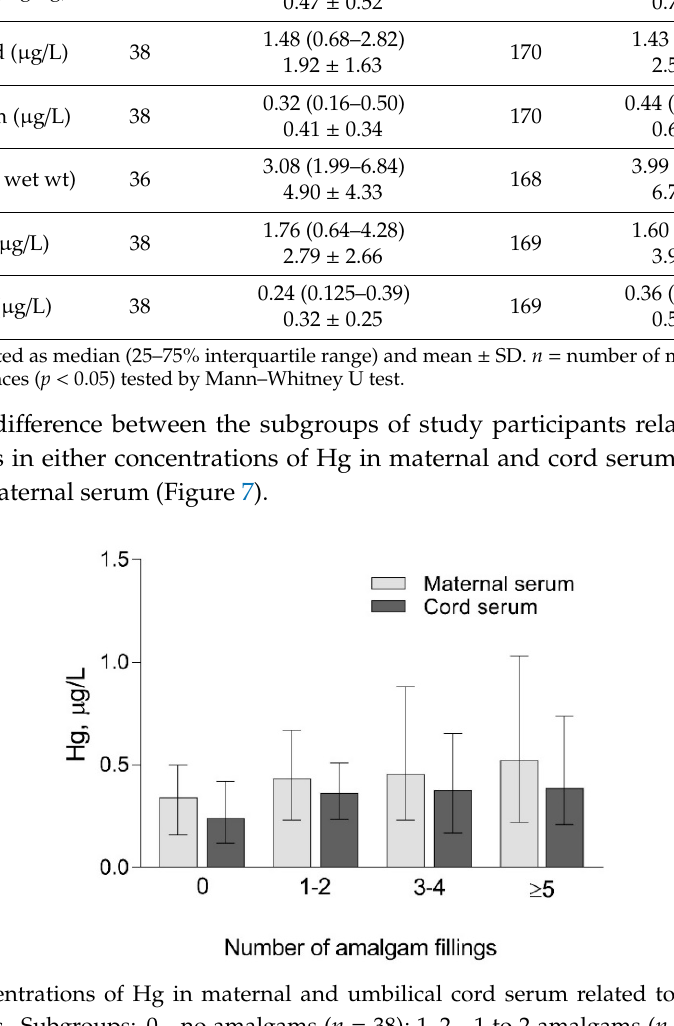
Figure 7. Concentrations of MT2 in maternal serum in the study participants from the coast ( n = 94) related to the number of amalgam fillings. Subgroups: 0—no amalgams ( n = 27); 1–2—1 to 2 amalgams ( n = 29); 3–4—3 to 4 amalgams ( n = 26); ≥ 5—5 or more amalgams ( n = 12). Data are presented as median and 25%–75% interquartile range. Spearman’s correlation coefficients (  s ) between maternal age, seafood (fish) consumption, number of amalgam fillings, maternal serum MT2, and the concentrations of Hg and Se in the measured samples are presented in Table 4. Maternal seafood intake positively correlated with virtually all the determined element biomarkers, except maternal hair Se. Good or strong correlations (  s = 0.62–0.86) were found between Hg levels in all measured samples of maternal and fetal origin and for Se in maternal blood and serum (  s = 0.8), whereas correlations between Se levels in other measured samples were weak (  s = 0.18–0.55). In all analyzed samples, the levels of Hg and Se were significantly positively correlated (  s = 0.19–0.52). MT2 concentration was inversely correlated with Se in maternal blood (  s = − 0.28), while maternal amalgam number (as represented in Table 1) was correlated with Hg in maternal and umbilical cord serum (  s = 0.16). Maternal age correlated with seafood intake, Hg in maternal and umbilical cord blood and serum, Hg in placenta, and Se in maternal blood and serum (  s = 0.12–0.2). These results, together with the significant correlations between Hg biomarkers and residence area, education, parity, and weight gain (results not shown), suggest a complex association among the variables. Each of these studied variables was therefore considered as potentially explanatory/confounding in their influence on Hg levels.